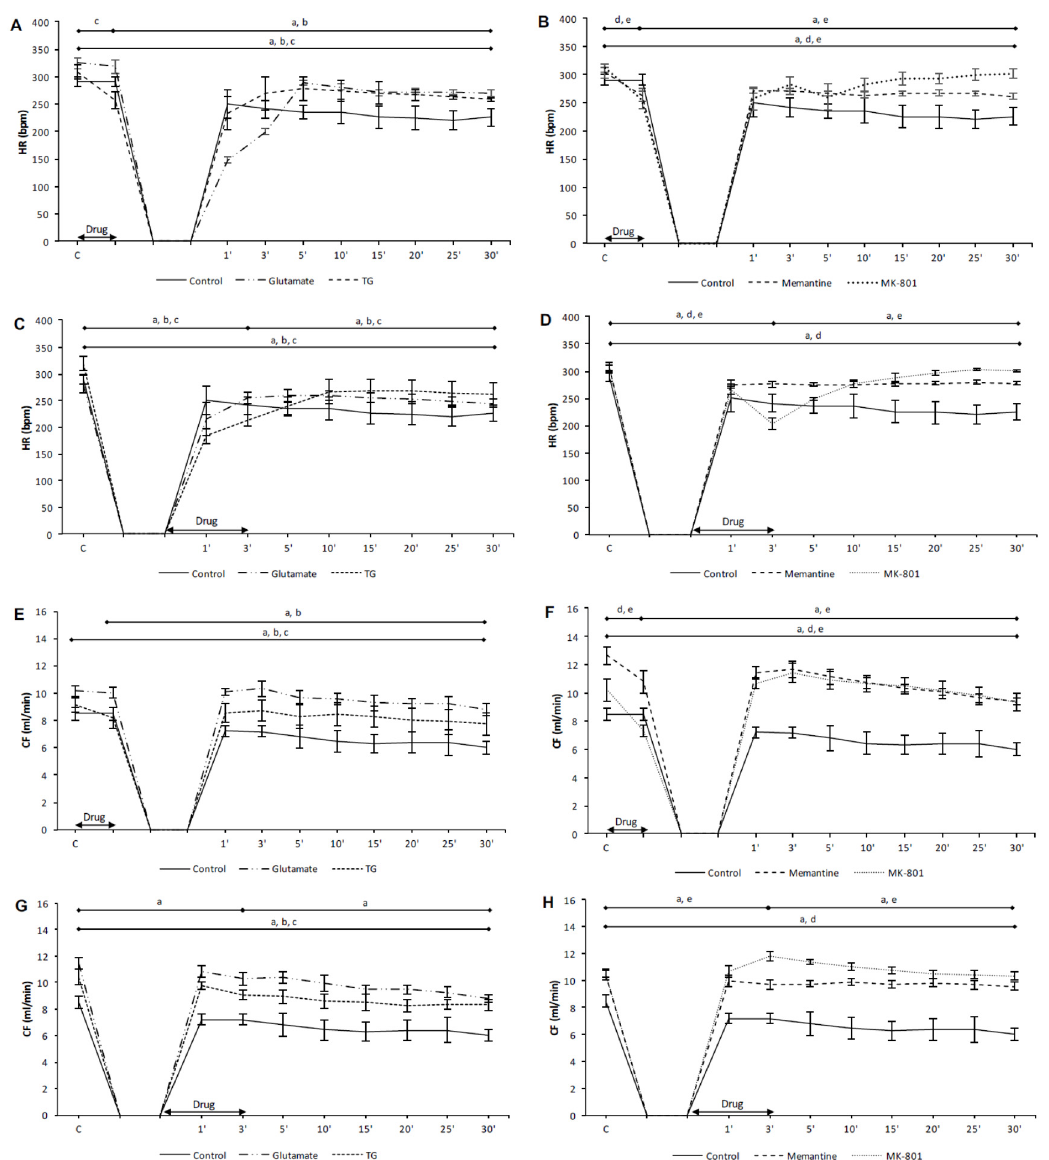
Figure 3. The effects of cardiac NMDAR modulation in preC and postC on heart rate and coronary flow. ( A , E ) preconditioned with glutamate and TG; ( B , F ) preconditioned with memantine and MK-801; ( C , G ) postconditioned with glutamate and TG; ( D , H ) postconditioned with memantine and MK-801. HR—heart rate; CF—coronary flow.